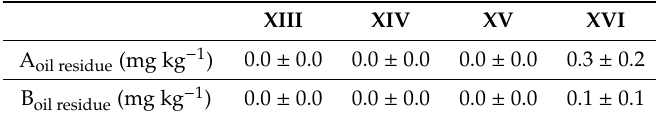
Table 8. Oil residues in fermentation residues, where: XIII = 1%, XIV = 5%, XV = 30% and XVI = 100% emulsion level, p -value =